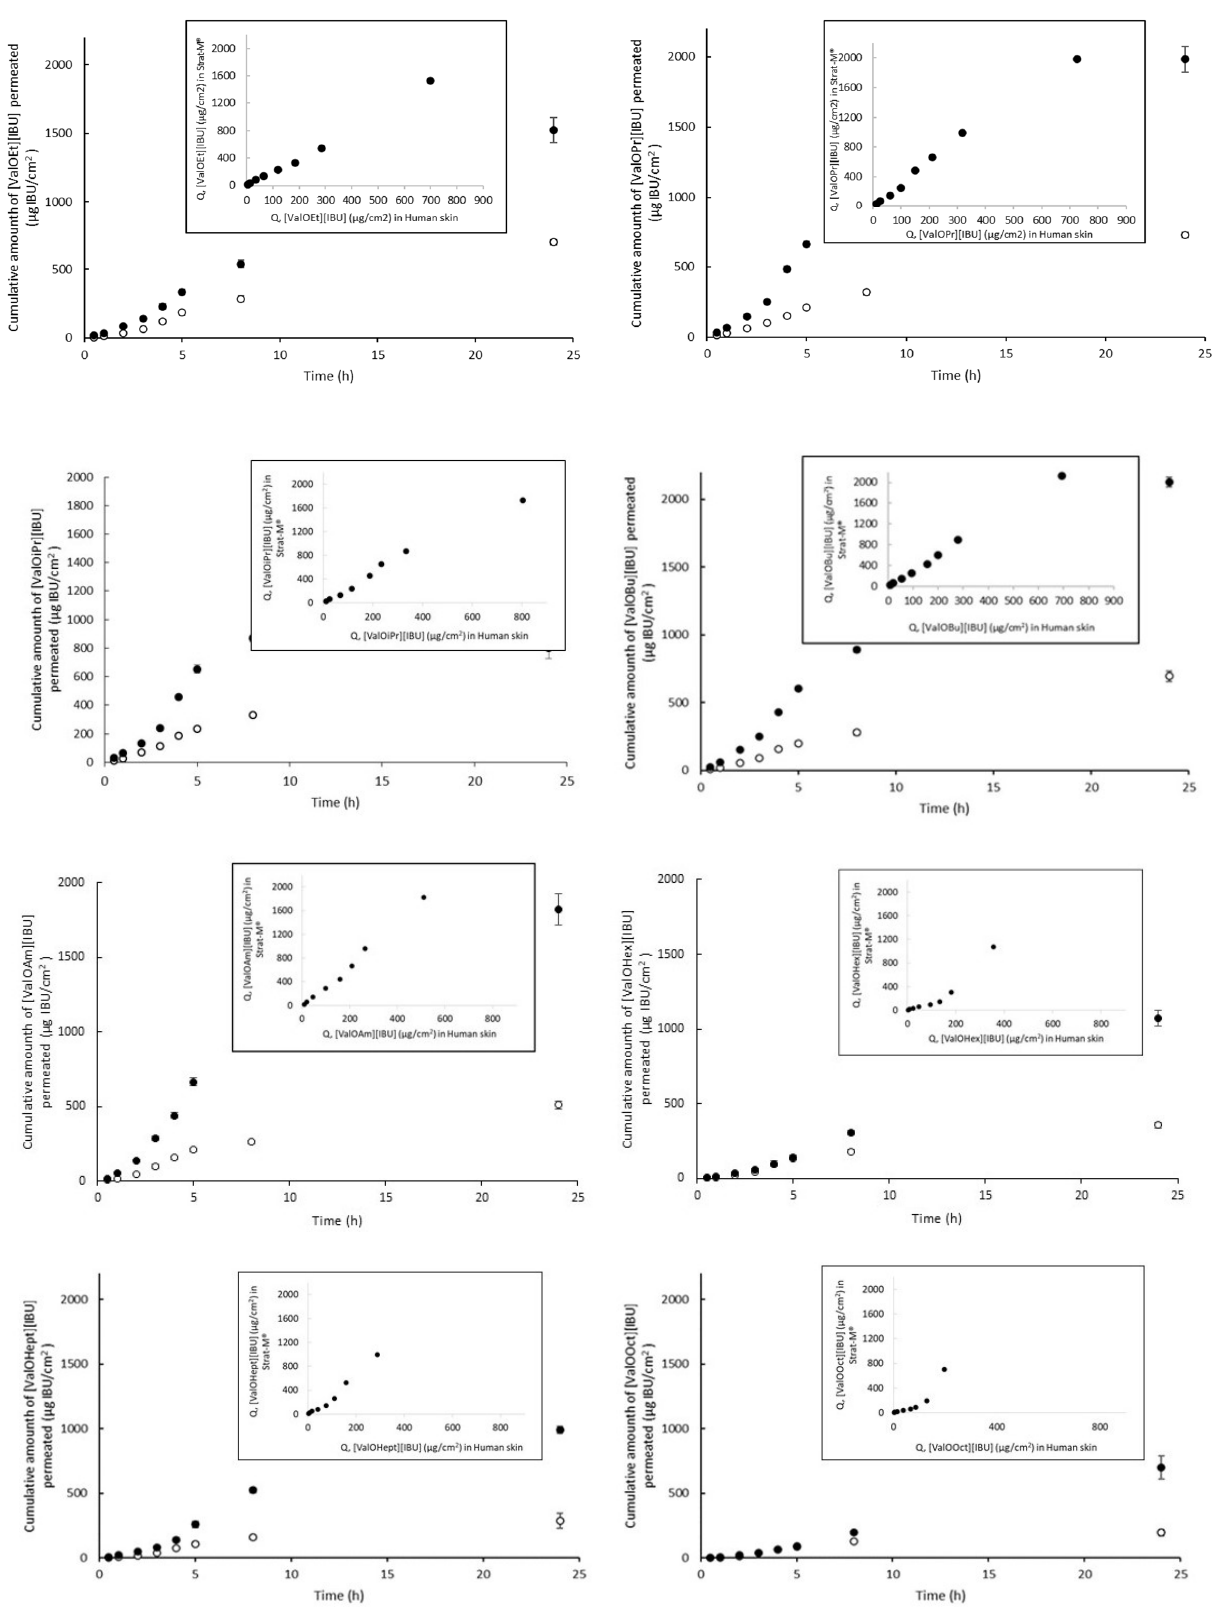
Figure 6. Comparison of average cumulative mass during 24 h penetration and correlation between human skin and transdermal diffusion test model for the compounds analyzed separately, Pearson’s test, p < 0.05.